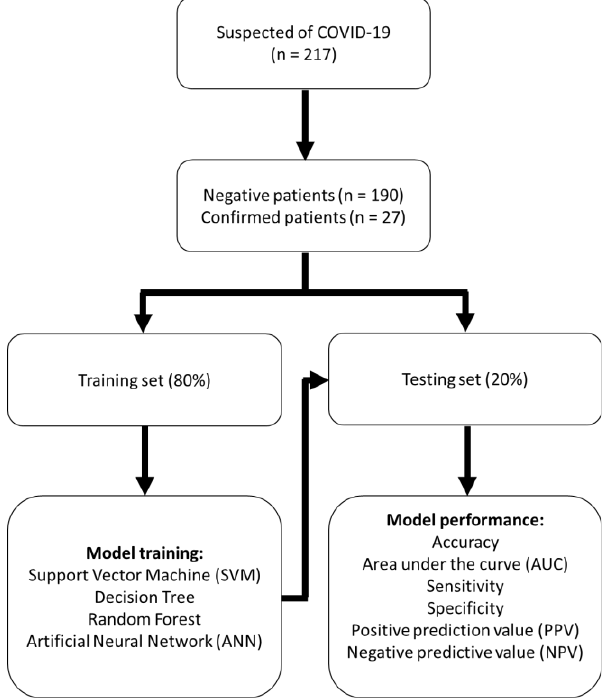
Figure 2. Flow chart of patients included in the model building and validation process.